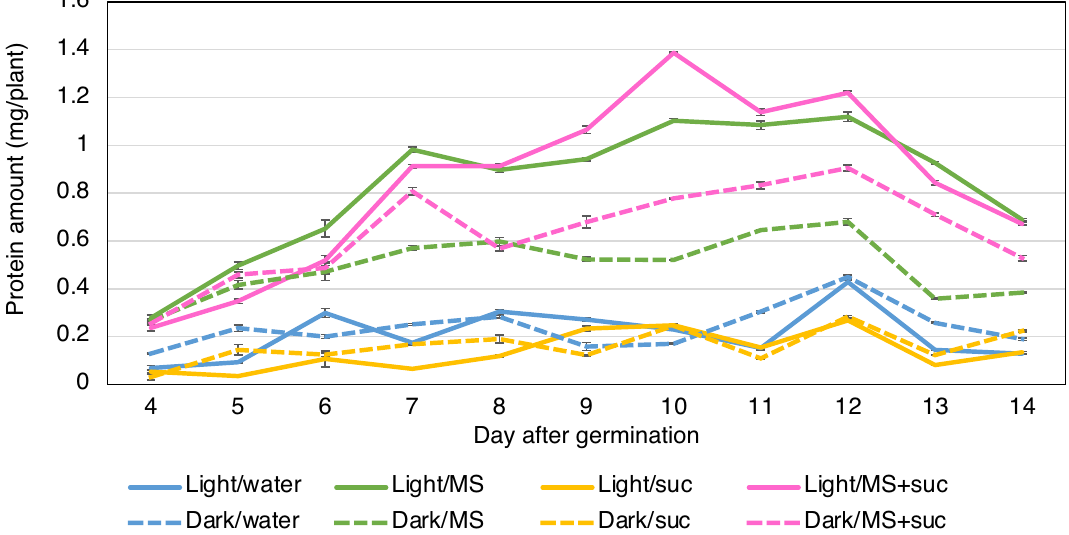
Figure 1. Protein production in rice seedlings grown under light and dark conditions with different nutritional supplements. The graph shows the amount of total soluble protein extracted from each seedling at 4–14 days after germination. Rice seeds were germinated in light or darkness and supplemented with Murashige and Skoog medium (MS) and/or 30 g/l sucrose